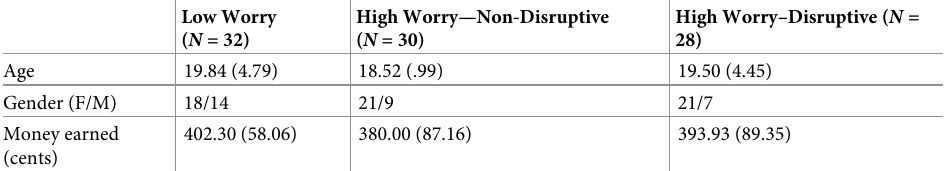
Table 1. Age, gender distribution, and money earned in the Attentional Bias Alignment Assessment Task (M, SD) for the three participant groups.